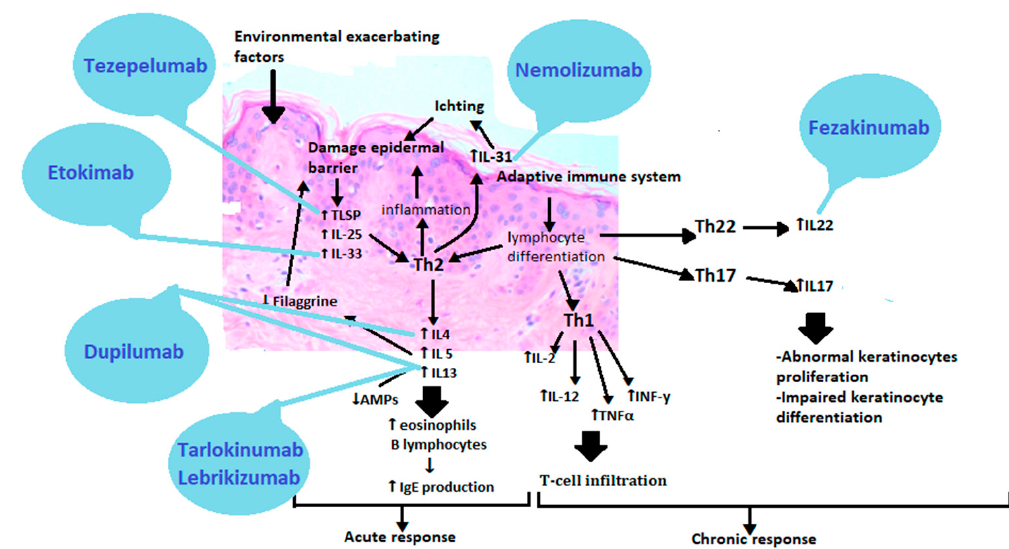
Figure 4. Therapies based on the pathogenesis of atopic dermatitis. TSLP(Thymic stromal lymphopoietin), IL25 (Interleukin 25), IL33 (Interleukin 33), Th2 (T helper cells 2), IL4 (Interleukin 4), IL5 (Interleukin 5), IL13 (Interleukin 13), IL31 (Interleukin 31), Th1 (T helper cells 1), IL2(Interleukin 2), TNF α (Tumor necrosis factor alpha), INF γ (Interferon gamma), Th22 (T helper cells 22), IL22 (Interleukin 22), Th17 (T helper cells 17), IL17 (Interleukin 17).